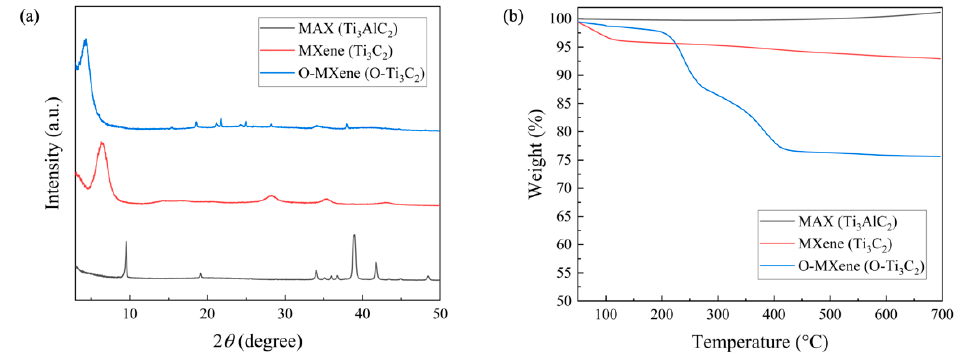
Figure 1. ( a ) XRD patterns of MAX phase (Ti 3 AlC 2 ), MXene nanosheets (Ti 3 C 2 ), and MXene–organic hybrids (O-Ti 3 C 2 ); ( b ) TGA curves of Ti 3 AlC 2 , Ti 3 C 2 , and O-Ti 3 C 2 .